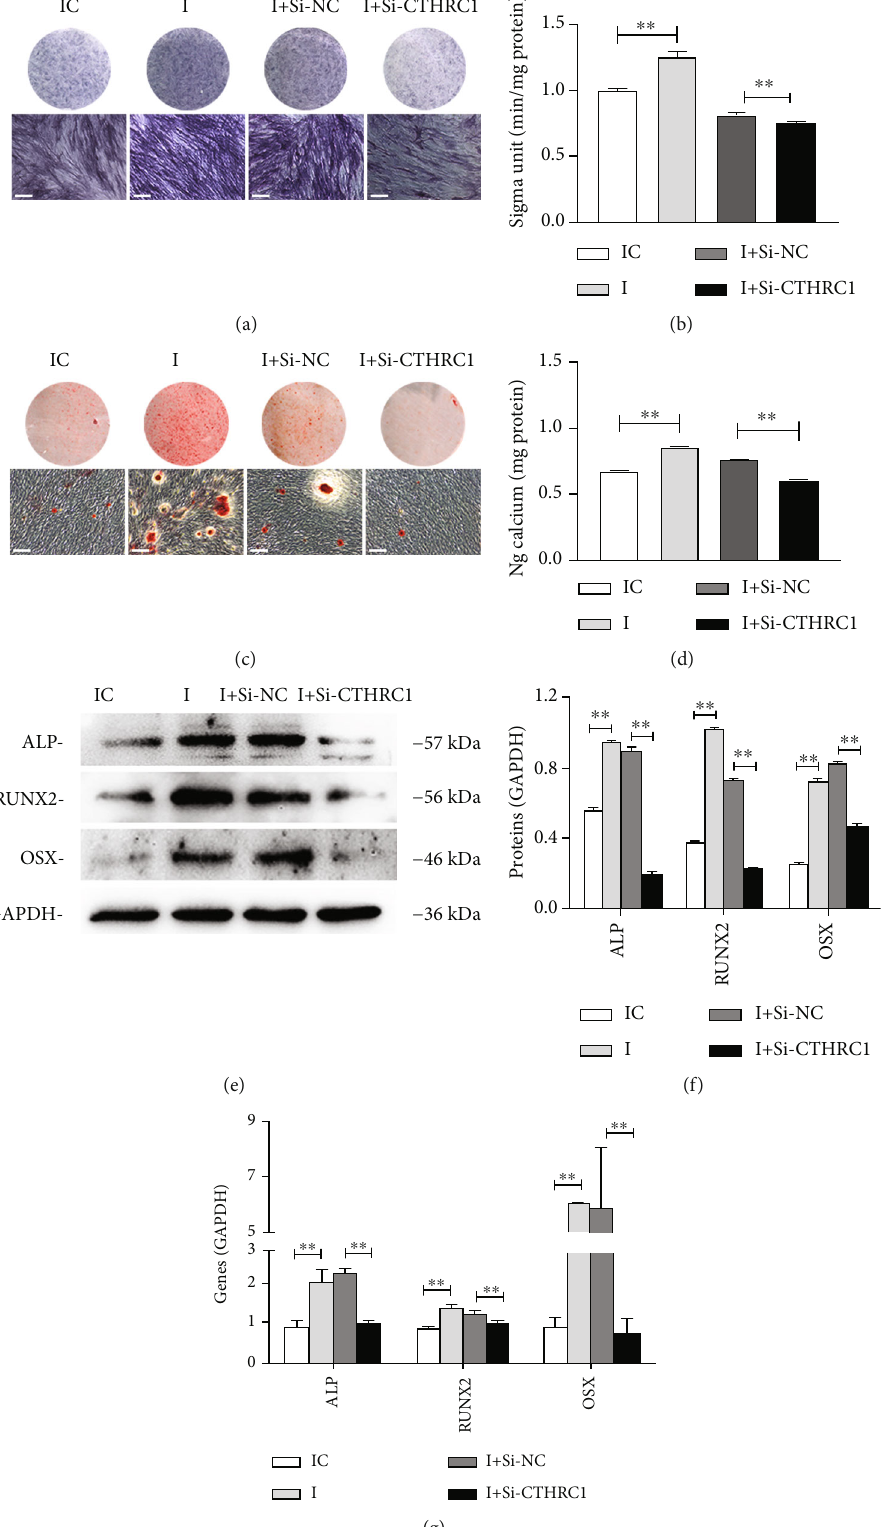
Figure 7: CTHRC1 partially reverses the in fl uence of hsa-let-7b on the osteogenic di ff erentiation of PDLSCs. (a, b) ALP staining and ALP activity analysis on day 7 in four group ( scalebar = 100 μ m ). ∗∗ P < 0 : 01 . (c, d) ARS staining and relative CPC assay were performed after osteogenic inducting 14 days ( scalebar = 100 μ m ). ∗∗ P < 0 : 01 . (e) Western blot analysis of ALP, RUNX2, and OSX. (f) Grayscale analyses of (c). ∗∗ P < 0 : 01 . (g) Relative mRNA expression of osteogenic genes. ∗∗ P < 0 : 01